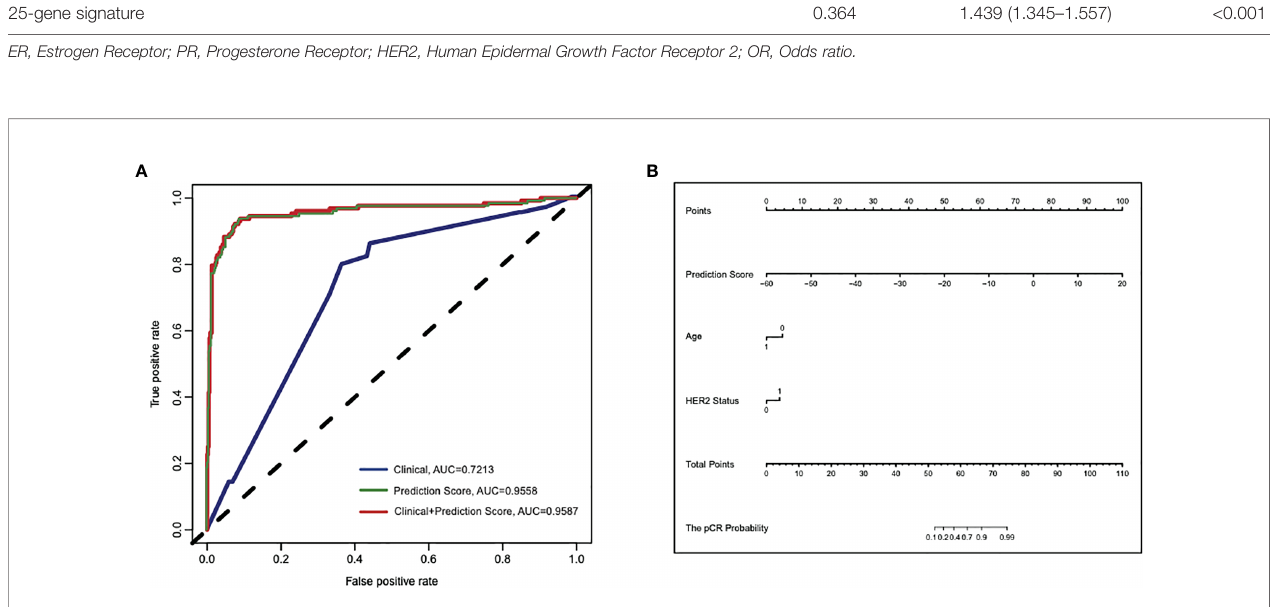
FIGURE 3 | Cross-validated ROC curves based on the multivariate logistic regression model for predicting pCR to paclitaxel and anthracycline-based neoadjuvant chemotherapy in breast cancer. (A) The area under ROC curve (AUC) of the 25-gene signature alone or in combination with clinical features were 0.9558 and 0.9587, respectively, compared with the lower AUC (0.7213) of the model that only included clinical features. (B) A constructed nomogram for predicting pCR to paclitaxel and anthracycline-based neoadjuvant chemotherapy in breast cancer. pCR, pathologic complete